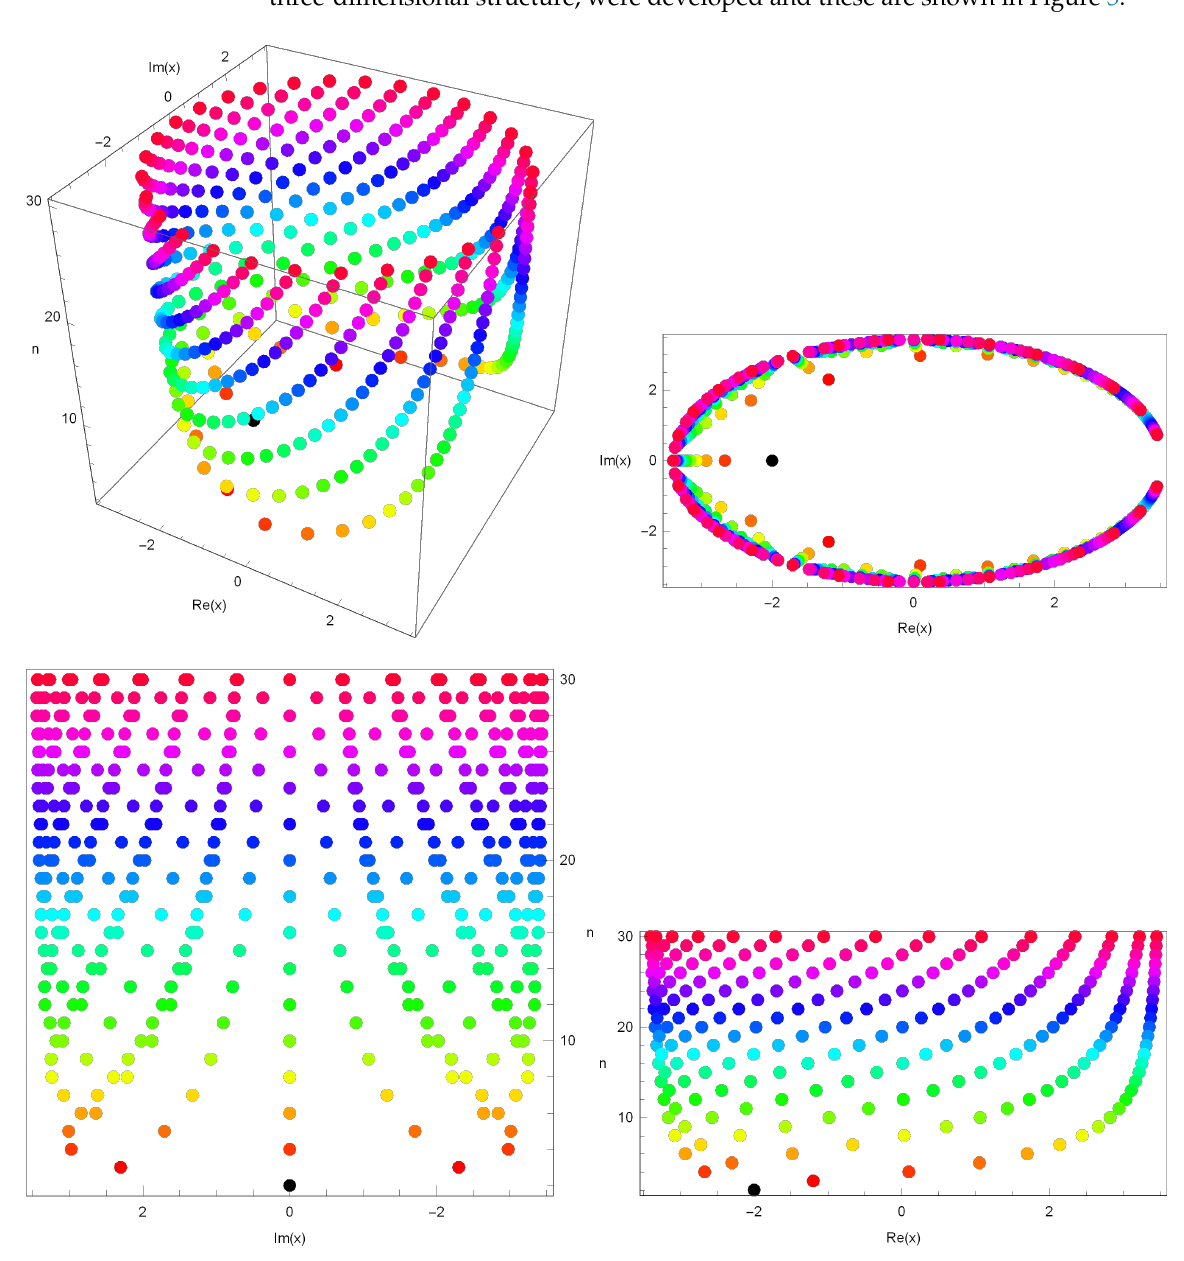
Figure 5. Stacking structure of approximation roots in ( p , q ) -sine geometric polynomials when 2 ≤ n ≤ 30, p = 1 , q = 1 , y = 3 and z = 2 in 2 10